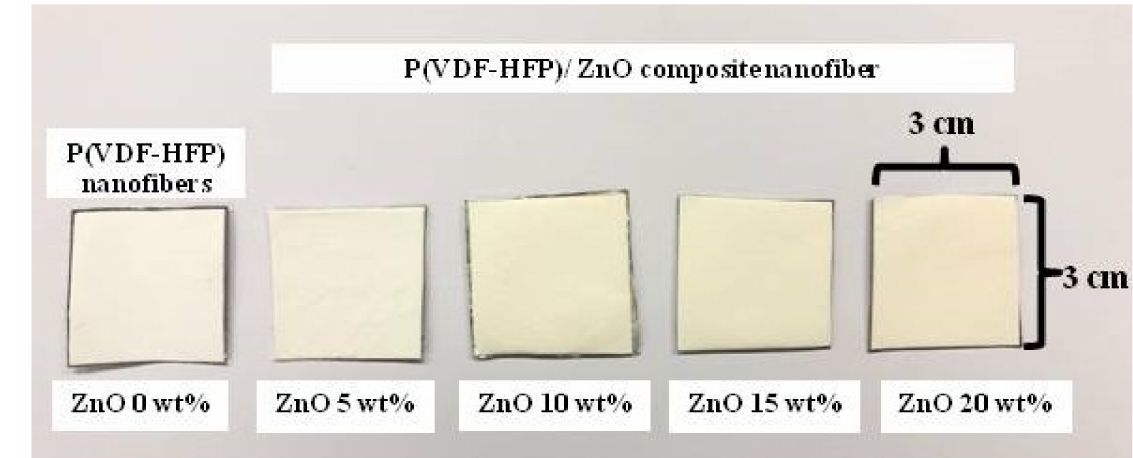
Figure 4. A photograph of specimens for P(VDF-HFP) nanofibers and P(VDF-HFP)/ZnO composite nanofibers (5, 10, 15, and 20